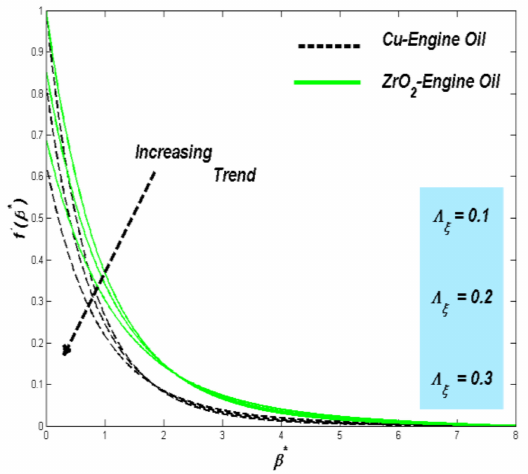
Figure 11. Velocity profile change with Λ ξ .